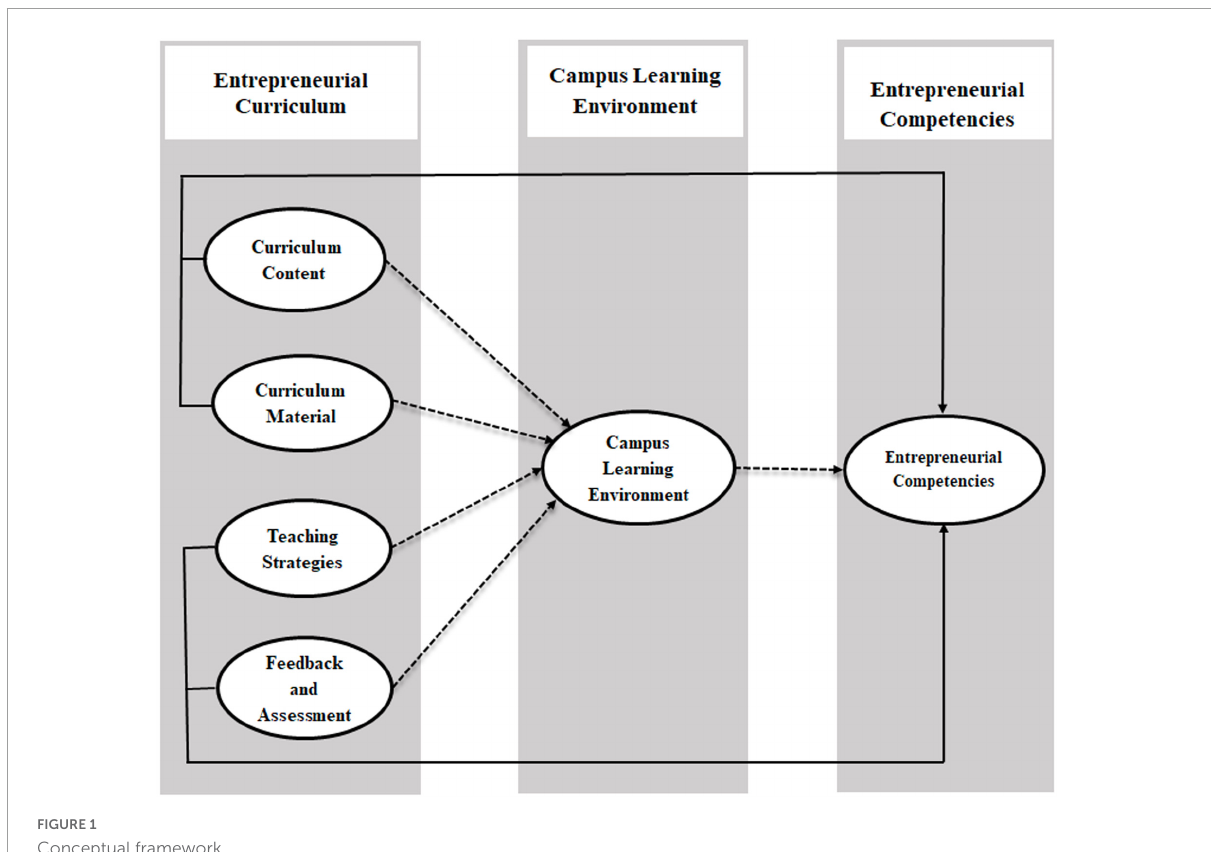
FIGURE1 Conceptual